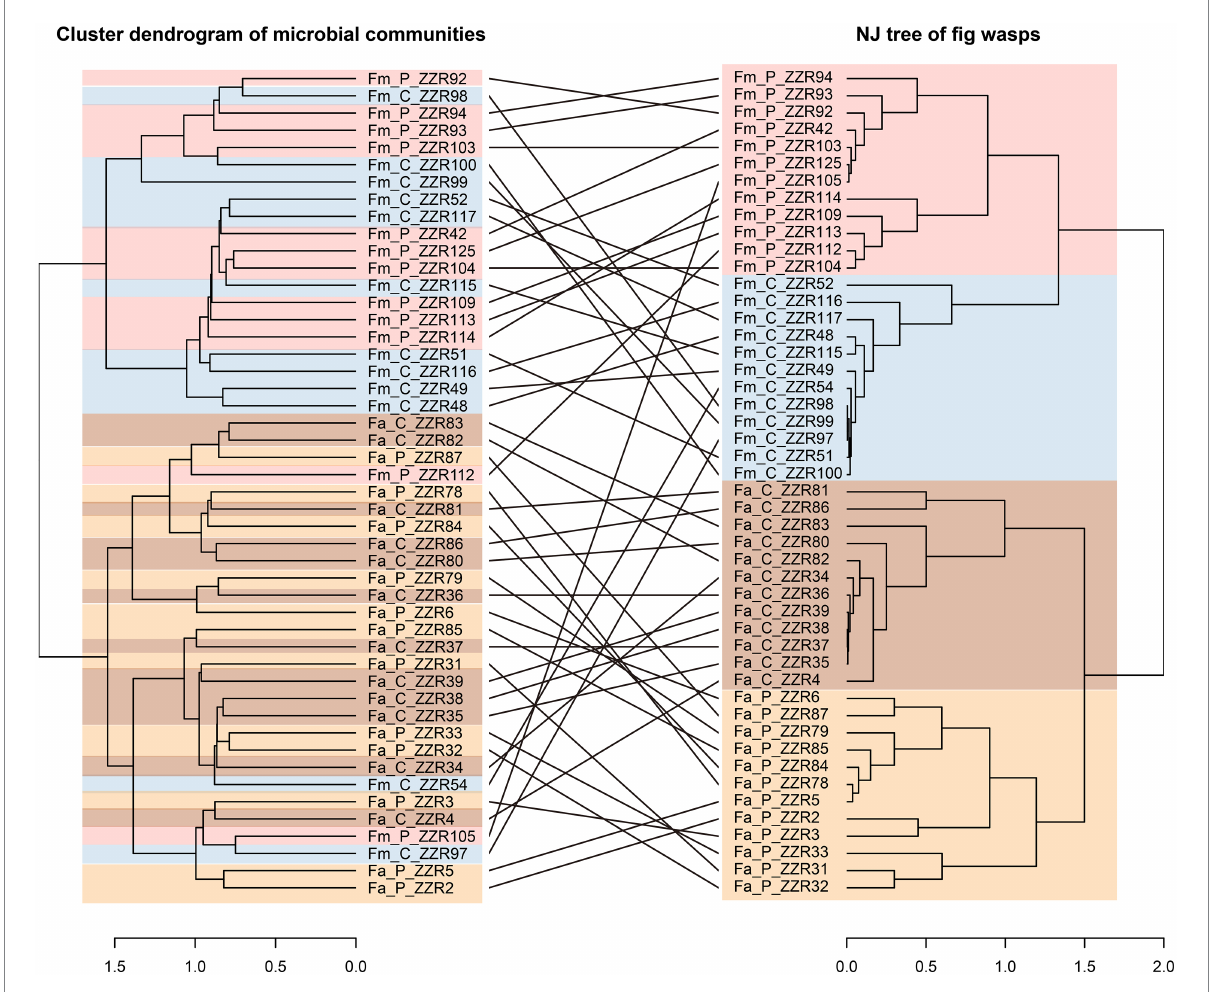
FIGURE 2 Left: the cluster dendrogram analysis based on the ward.D2 method using Euclidean distances of compositions of microbial communities in samples. The tip labels in the dendrogram are the sample codes. Right: the phylogenetic structure of fig wasps, (the corresponding relation: m 2 XY = 0.72, p < 0.001, n = 1,000). Fa_C represents the cheater of F. altissima ; Fa_P represents the pollinator of F. altissima ; Fm_C represents the cheater of F. microcarpa ; Fm_P represents the pollinator of F. microcarpa